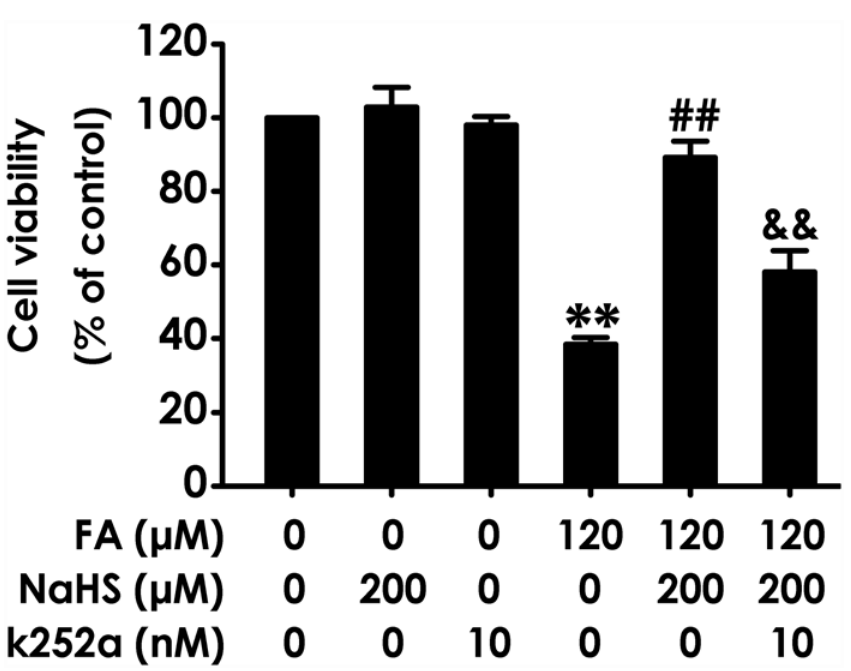
Fig 3. Effect of K252a on H 2 S-induced protection against formaldehyde-exerted cytotoxicity in PC12 cells. PC12 cells were preincubated with K252a (10 nM) for 30 min before pretreatment with NaHS (200 μ M) for 30 min, and then cotreated with formaldehyde (FA, 120 μ M) for 24 h. Cell viability was determined by the CCK-8 assay. Results were expressed as the mean ± S.E.M. of three independent experiments. ** P < 0.01, versus control group; ## P < 0.01, versus FA-treated alone group; && P < 0.01, versus cotreatment with NaHS and FA